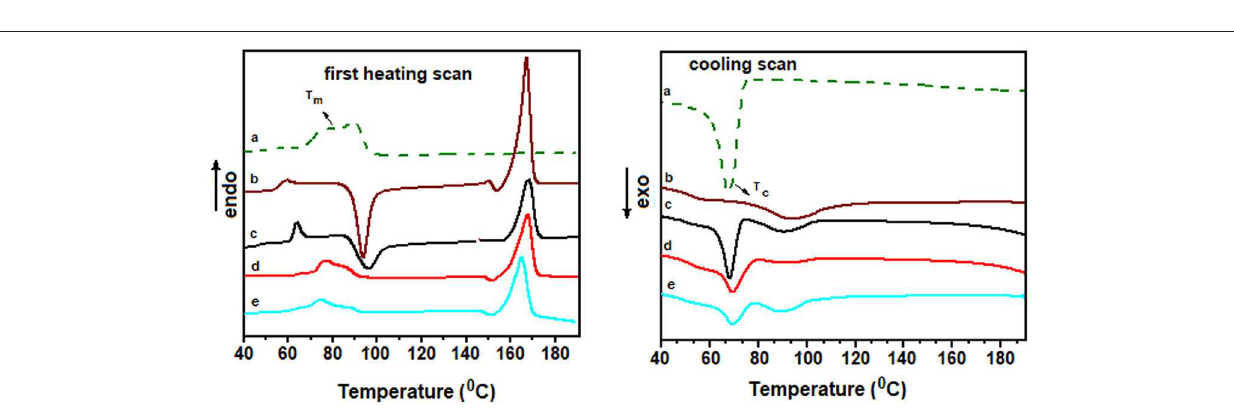
Figure 6 . The samples were obtained directly from the